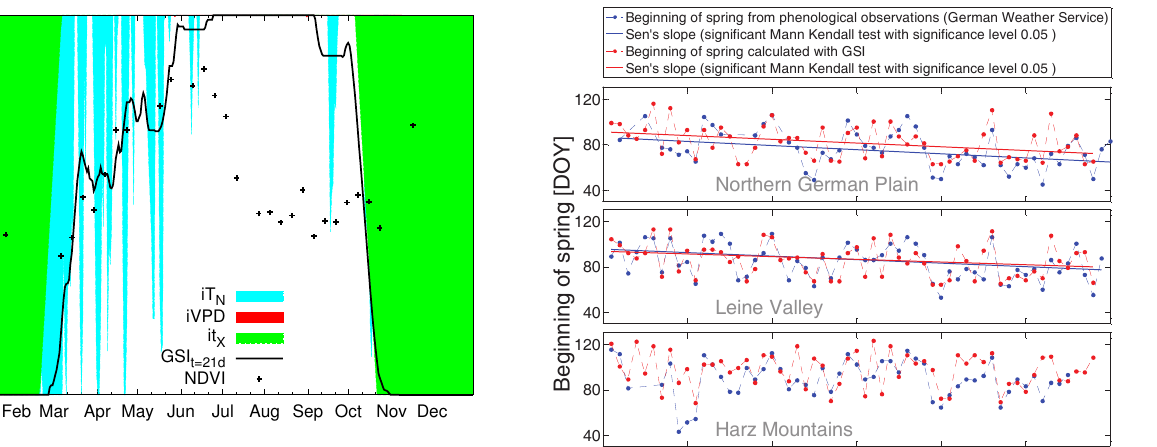
Fig. 4. Left panel: GSI courses of individual years and fitted mean GSI courses for an example sub-catchment. The points d n separate the mean course into 4 linear ranges which can easily be calculated from elevation. Right panel: Values of d n were calculated for each sub-catchment in south-eastern Lower Saxony (4500 in total). Regression functions were derived for each d n by plotting day of year for d n against sub-catchment elevation.